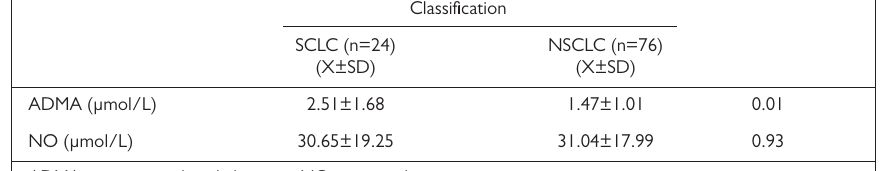
Table 3. Distribution of ADMA and NO levels according to histopathological classification